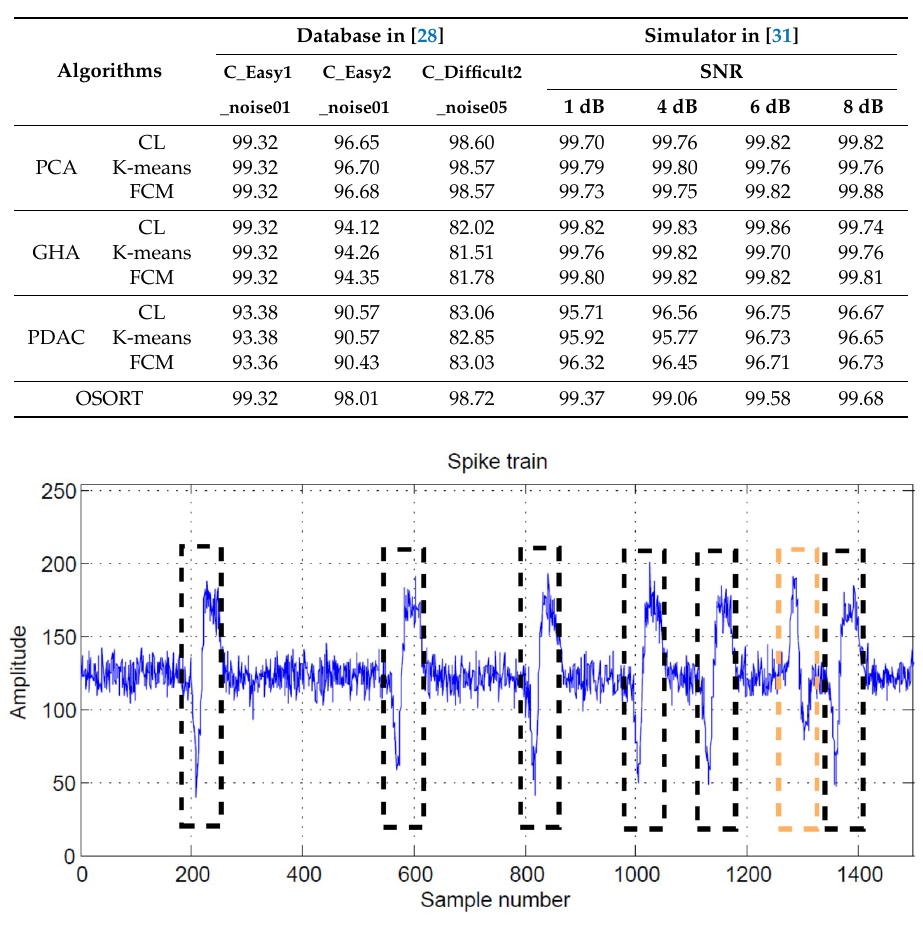
Figure 11. A segment of the waveform of a spike train produced by the simulator in [31]. There are two classes of spikes (i.e., K = 2). Spikes belonging to the first class and the second class are marked by black rectangles and orange rectangles,